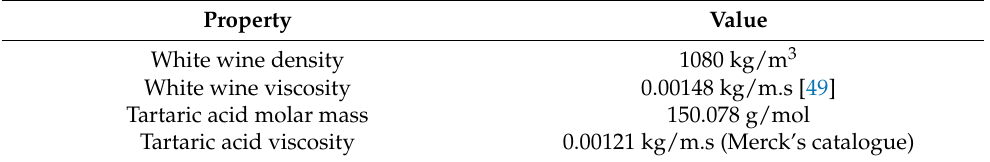
Table 3. Physical properties of white wine and tartaric acid at RT (25 ◦